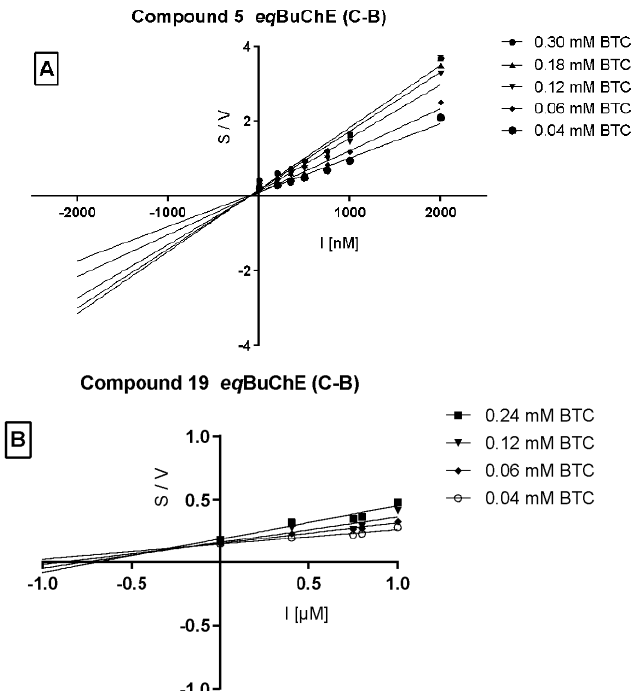
Figure 5. Cornish – Bowden plot illustrating non-competitive type of eq BuChE inhibition by com- pound 5 panel ( A ) and mixed type of enzyme inhibition by compound 19 panel ( B ). S = butyrylthi- ocholine; V = initial velocity rate, I = inhibitor concentration.